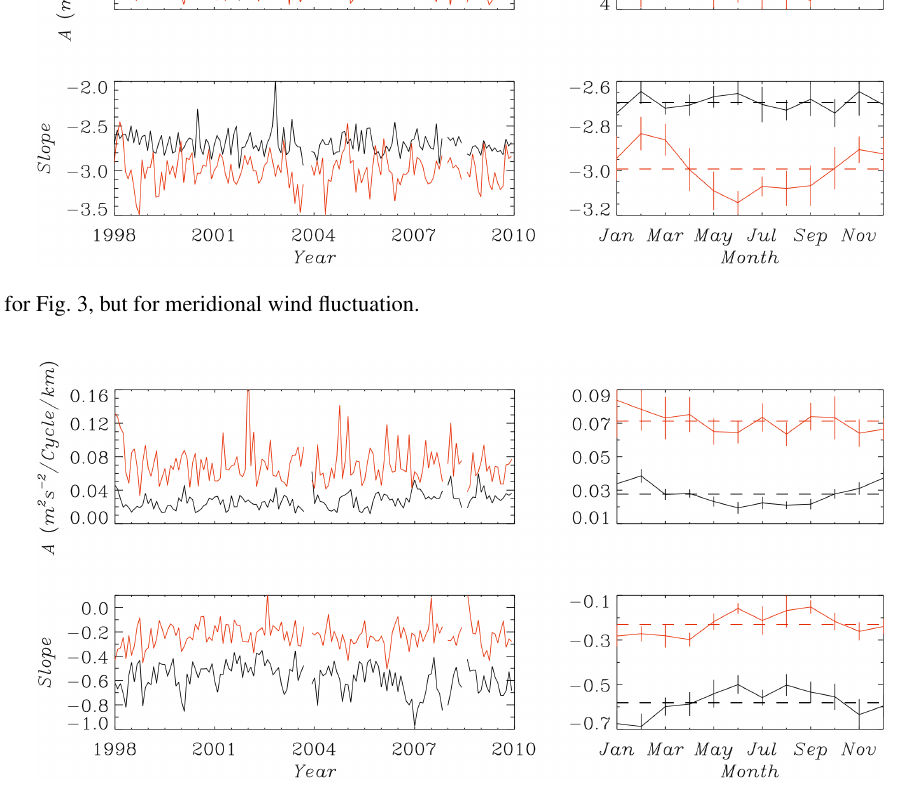
Figure 5. Same as for Fig. 3, but for vertical wind